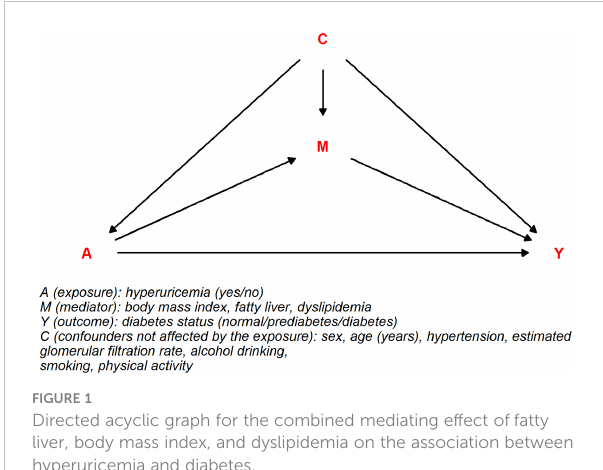
FIGURE 1 Directed acyclic graph for the combined mediating effect of fatty liver, body mass index, and dyslipidemia on the association between hyperuricemia and